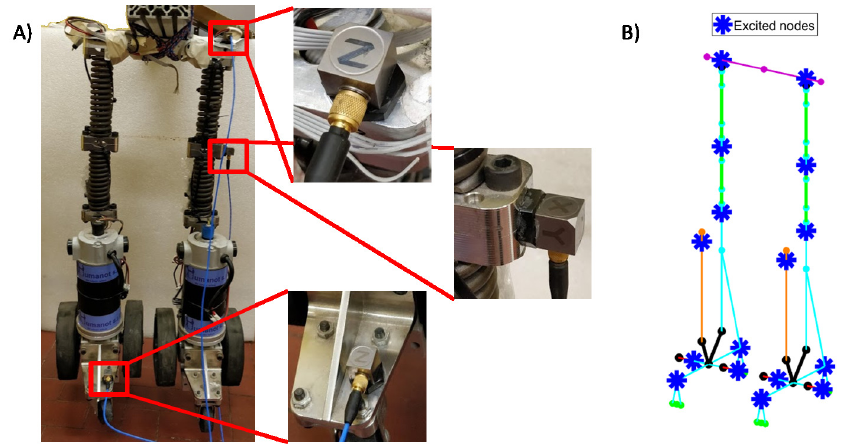
Figure 4. ( A ) Experimental setup and accelerometer locations, ( B ) excited nodes.